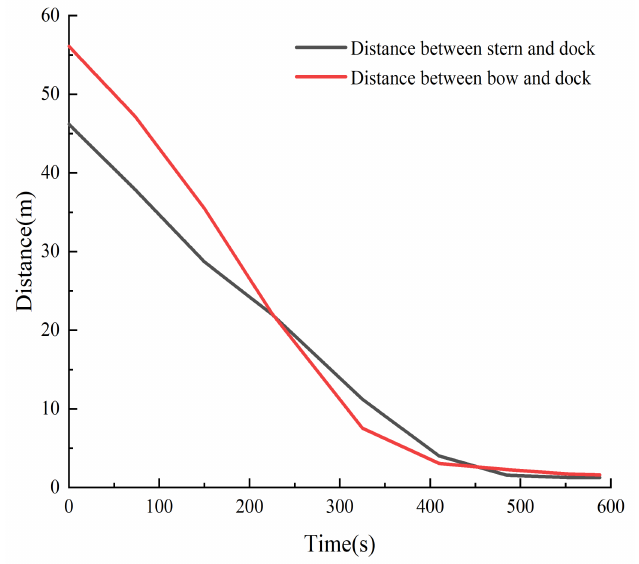
Figure 17. Distances of the stern and bow relative to the dock.